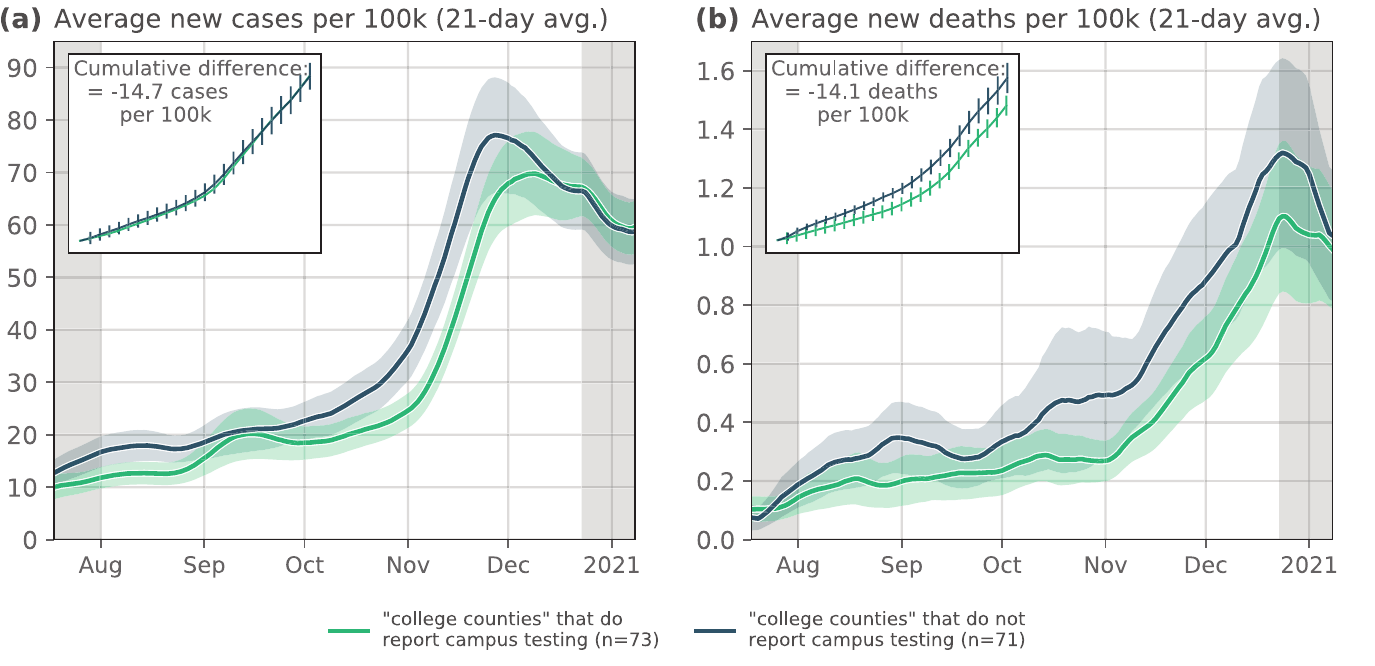
Fig 3. Comparing counties with IHEs that reported any vs. zero COVID-19 tests. As in Fig 2, we compare the average (a) new cases and (b) new deaths per 100,000 in counties with IHEs reported conducting any COVID-19 tests vs. counties with IHEs that reported no tests. Note: if there are multiple IHEs in a single county, we sum together the total number of tests between all IHEs. (Ribbons: 95% confidence